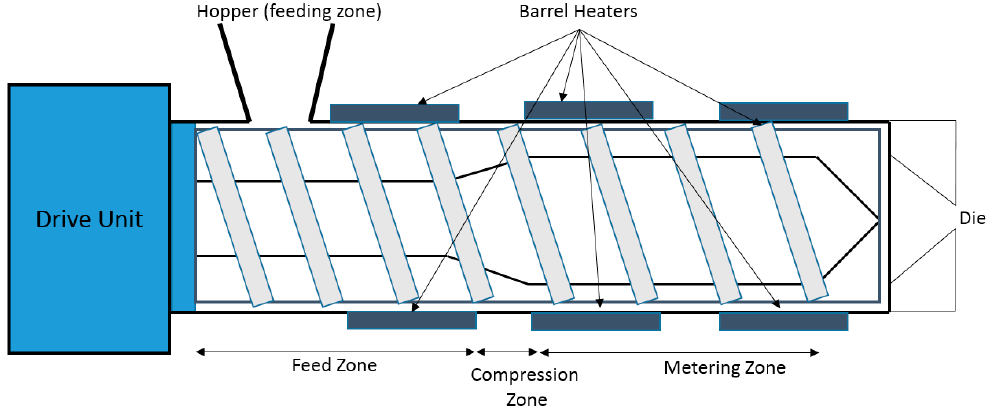
Figure 5. Three different zones of a screw in an extruder: Feeding, compression/melting and metering zone.